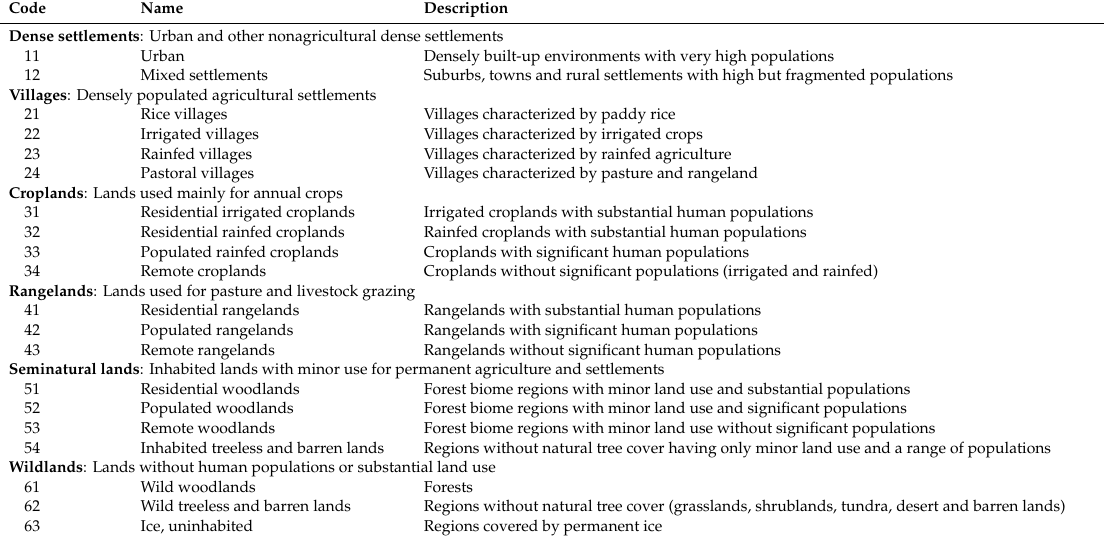
Table 1. Anthromes 2.1 classification, including six anthrome levels, including Wildlands and 20 anthromes classes (Appendix